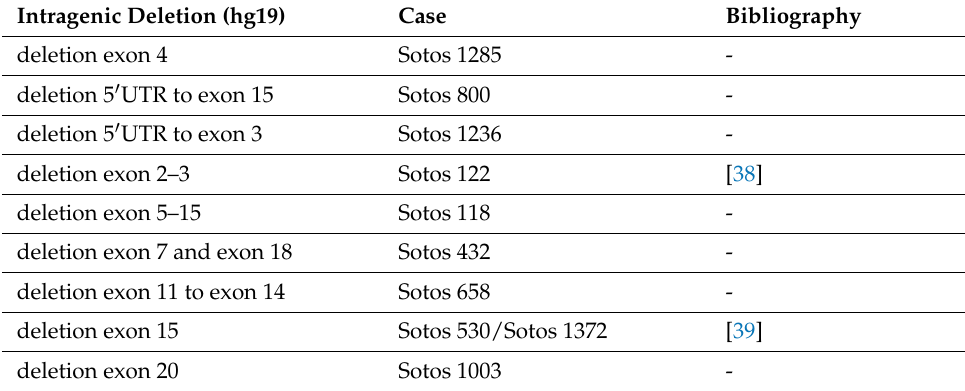
Table 3. Intragenic